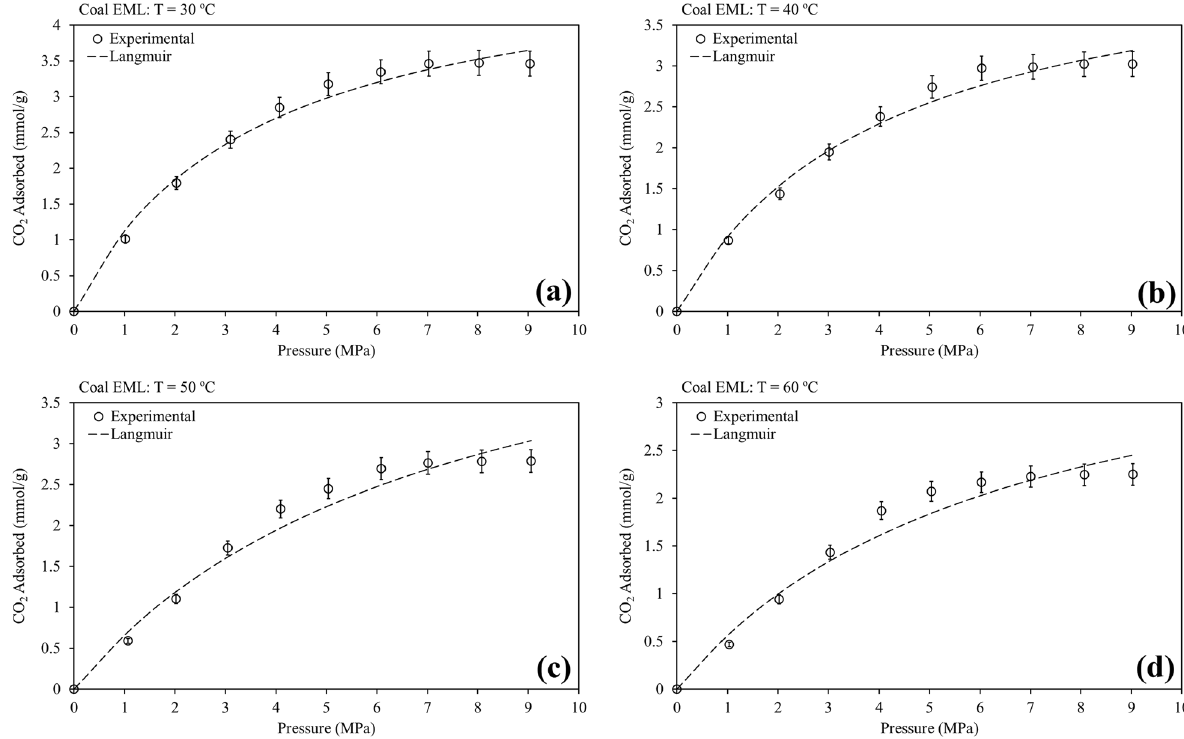
Fig. 1 Langmuir isotherm model fit for pure CO 2 sorption on Coal EML at a 30 ºC, b 40 ºC, c 50 ºC, and d 60